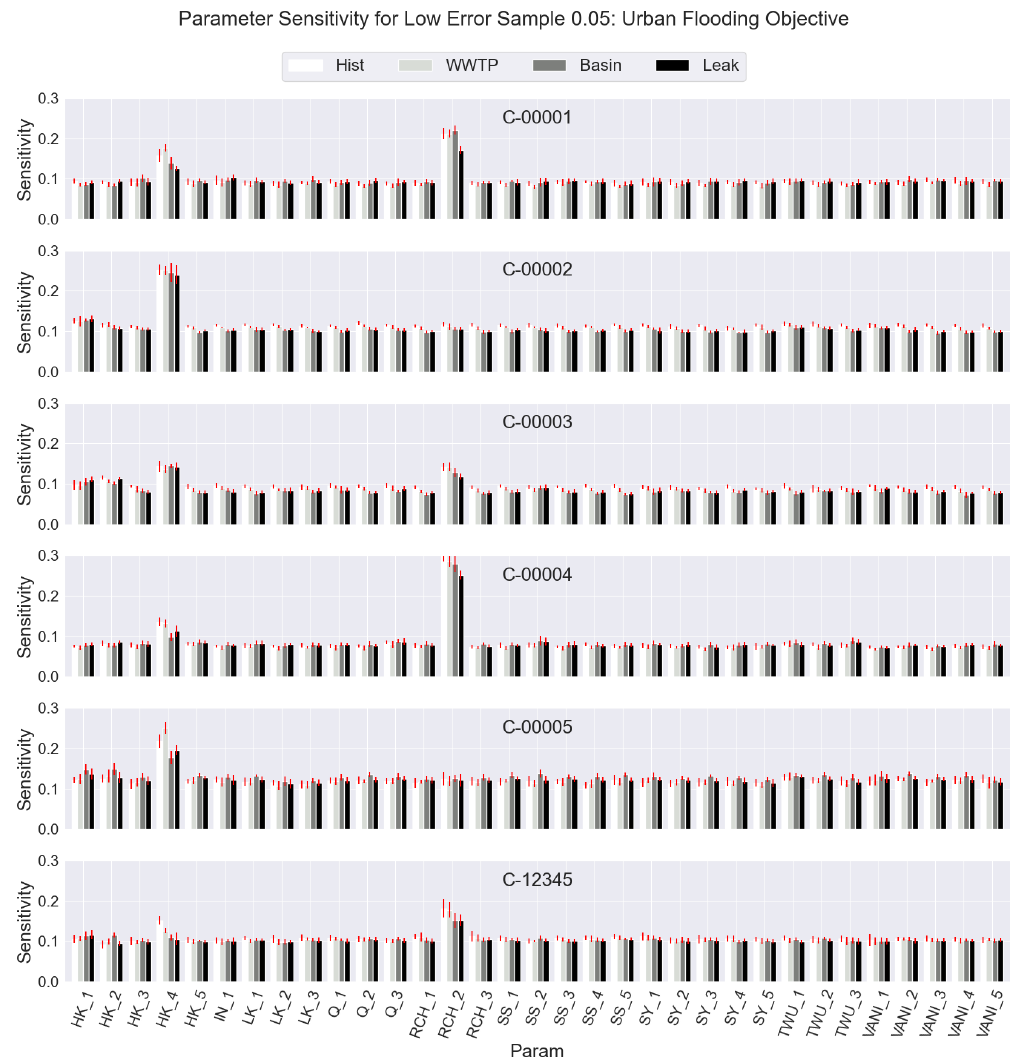
Figure A3. δ sensitivity of the urban flooding risk objective according to the 5000 filtered samples for the 33 model parameters (columns). The sensitivity is shown by cluster (rows) and by the four alternatives from left to right (light to dark), i.e., historical, wastewater reuse, infiltration basins, and repair